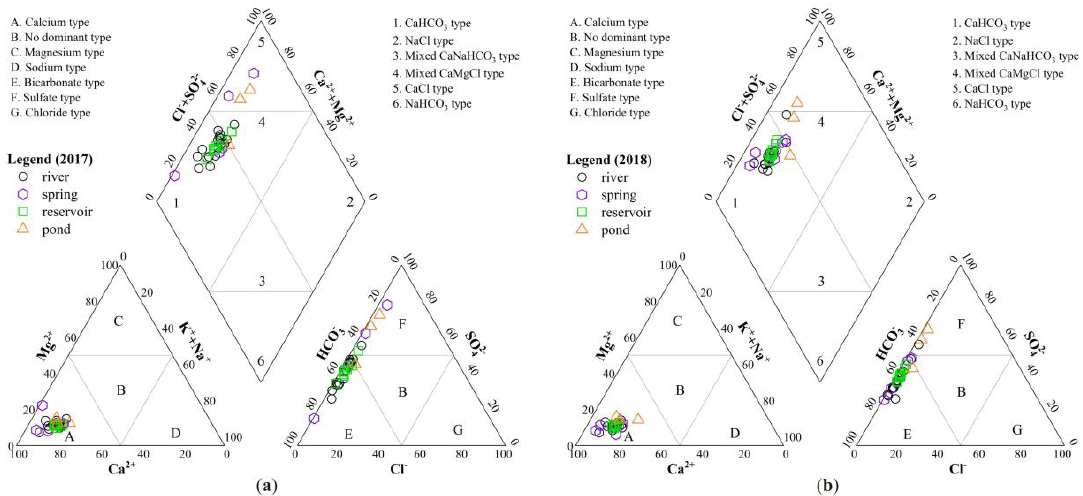
Figure 7. The piper diagram of the surface water and groundwater in ( a ) 2017 and ( b ) 2018.